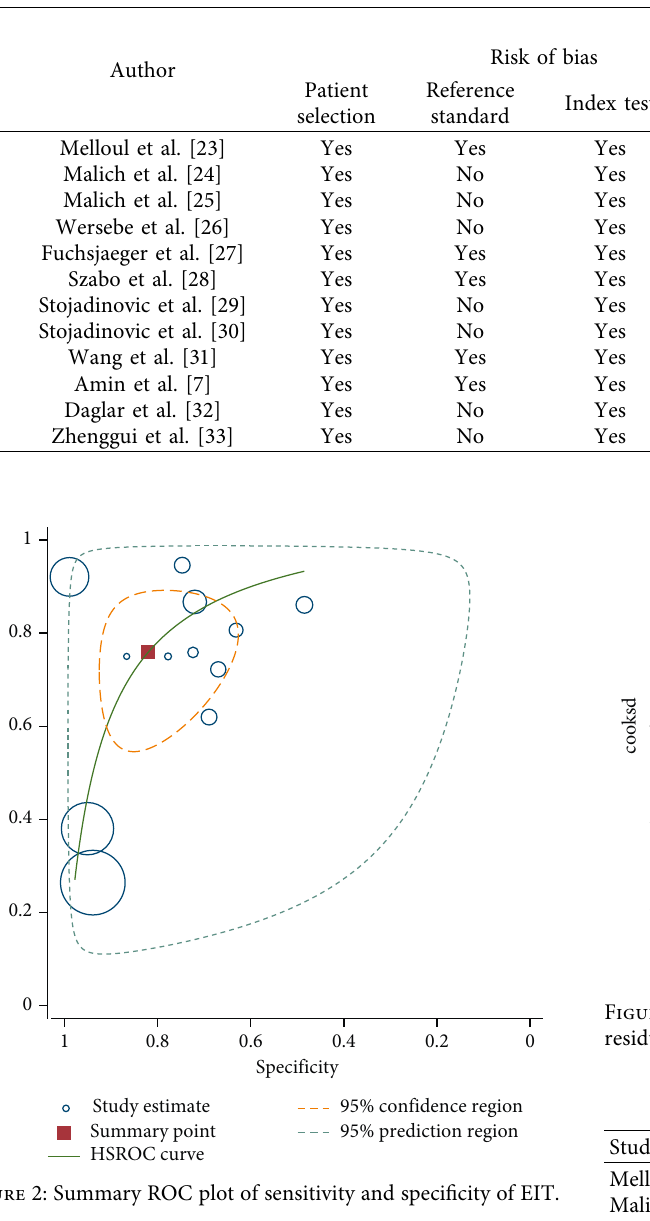
Table 2: QUADAS for the included